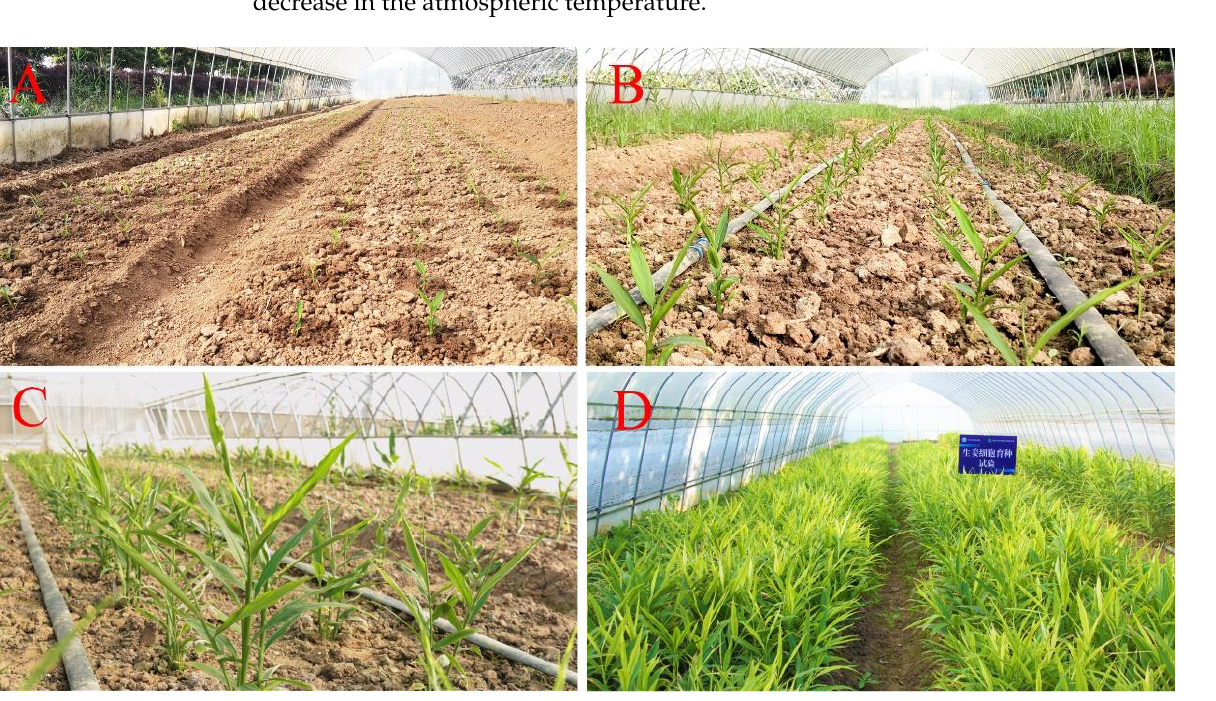
Figure 1. Field performance of the disease-free ginger plants cultivated in a simple plastic greenhouse under natural conditions. Photographs were taken 0 d ( A ), 30 d ( B ), 60 d ( C ) and 150 d ( D ) after planting, respectively.